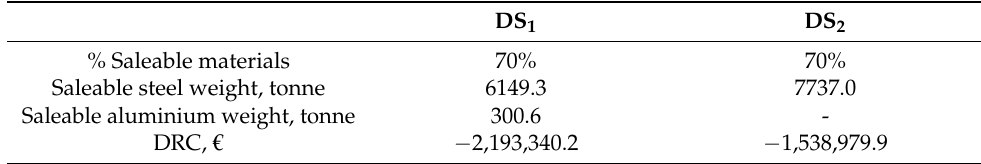
Table 4. Dismantling revenues for the analysed case